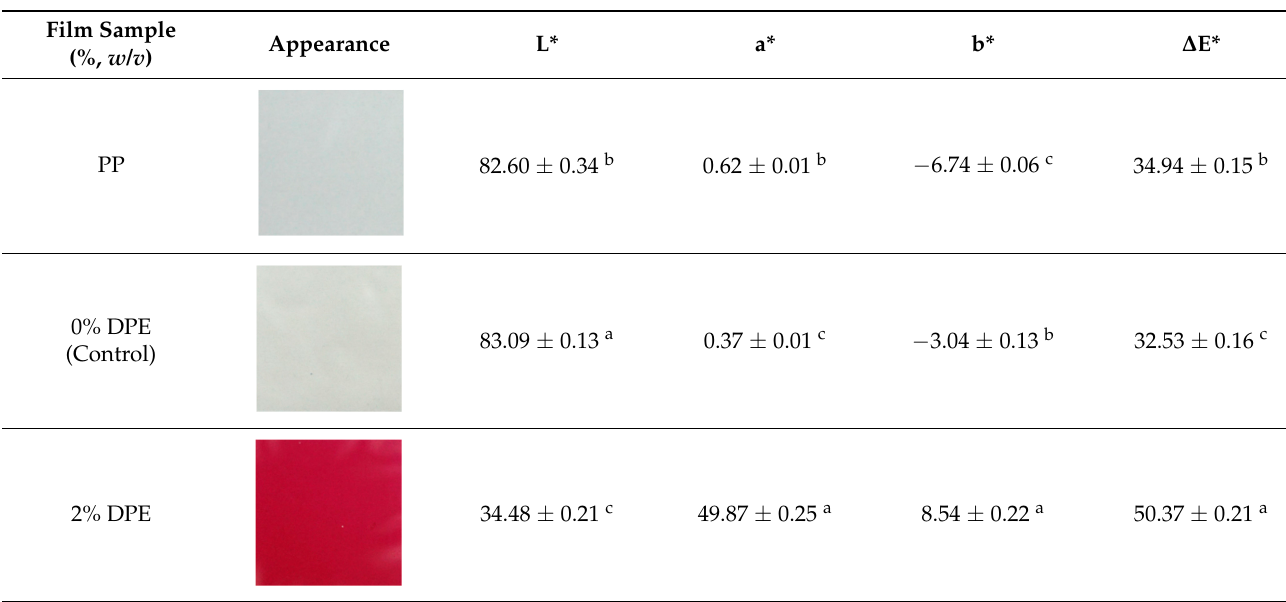
Table 3. Bioactive compound and antioxidant properties of the